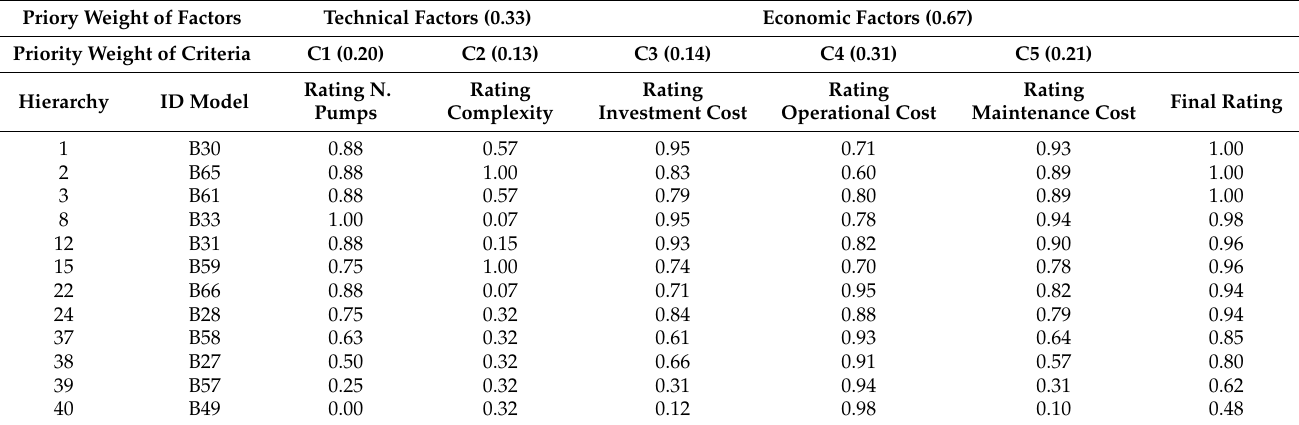
Table 9. Rating of the criteria and overall rating for each alternative